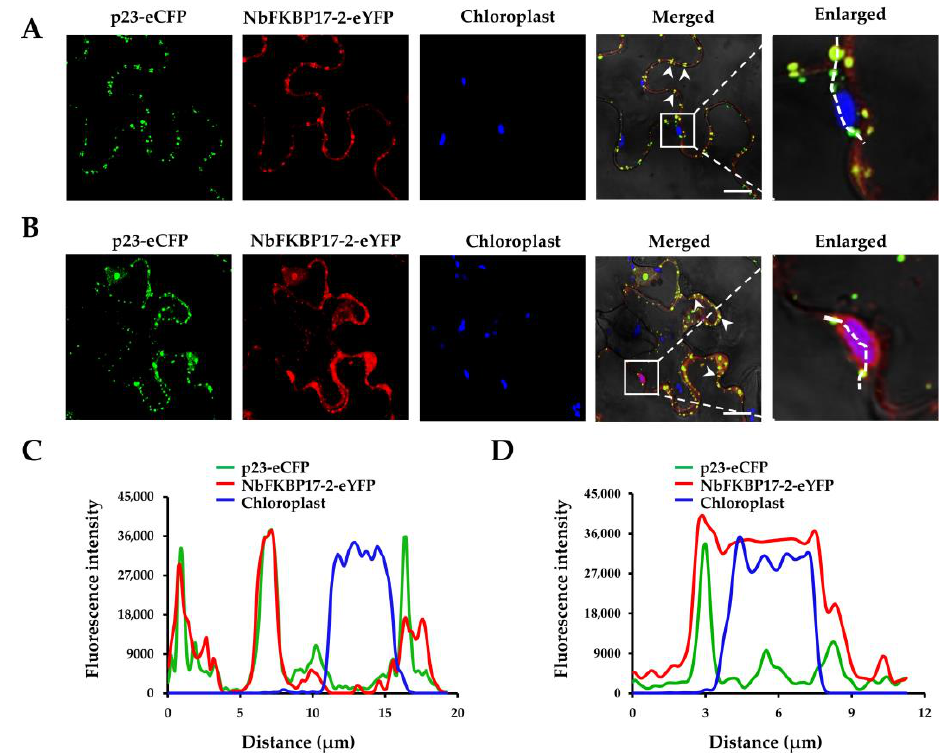
Figure 3. Subcellular co-localization analyses of p23-eCFP and NbFKBP17-2-eYFP in Nicotiana benthamiana epidermal cells. ( A , B ) represented two different visual fields showing the co-localization of p23 and NbFKBP17-2 at plasmodesmata (PD) ( A ) and partial fluorescent signals of NbFKBP17-2 on chloroplasts ( B ), respectively. The white boxes indicated areas showing a magnified view. Arrows point to PD. The blue signals represented the chlorophyll autofluorescence in chloroplasts. Confocal images were taken at 48 hpi. Bars, 20 μm. ( C , D ) showed overlapping fluorescence spectra of eCFP, eYFP and chloroplast signals along the white dots depicted in ( A , B ), respectively.